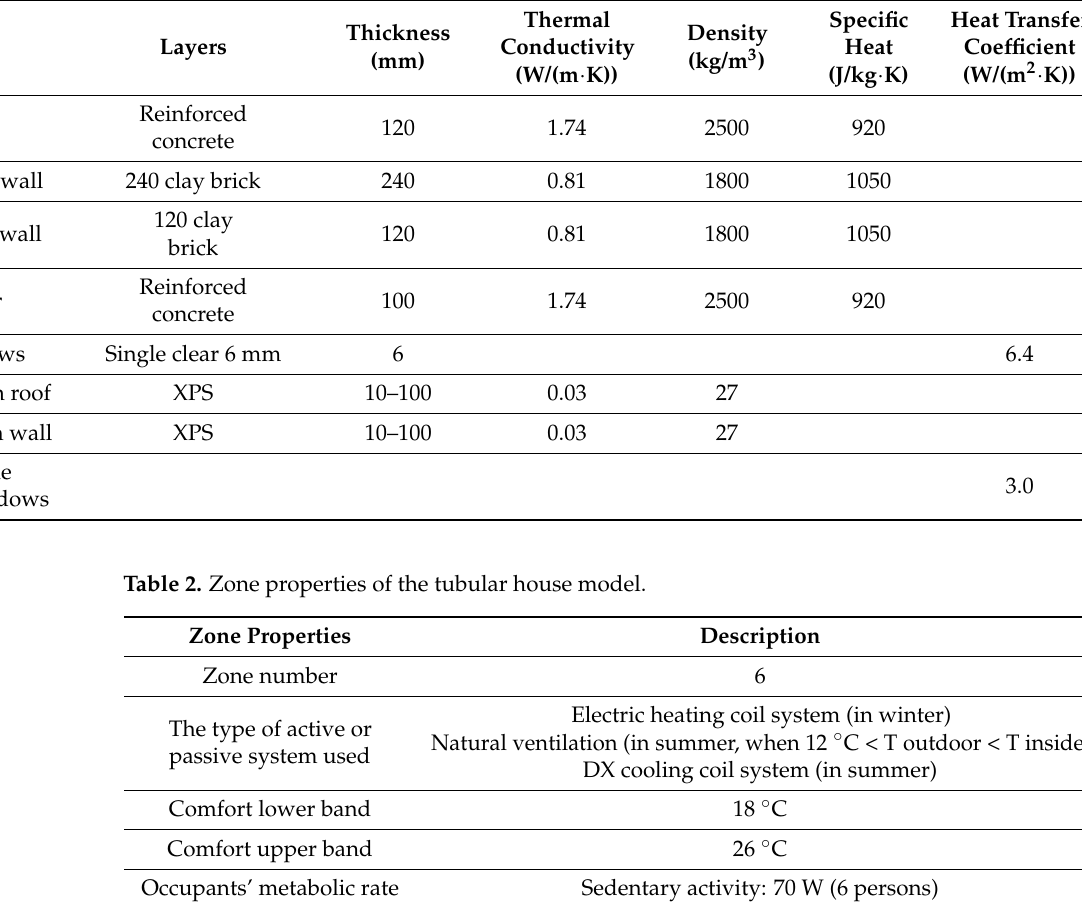
Table 1. Material descriptions of the tubular house model.